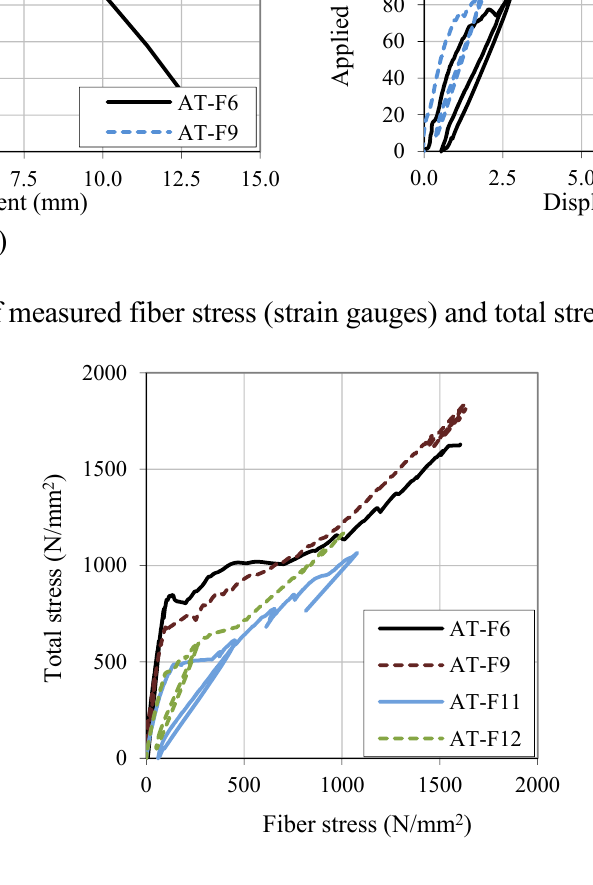
Figure 10. Load-displacement curves of Series AT-F. ( a ) C-Sheet 200 g/m 2 ; ( b ) C-Sheet 400 g/m 2 .